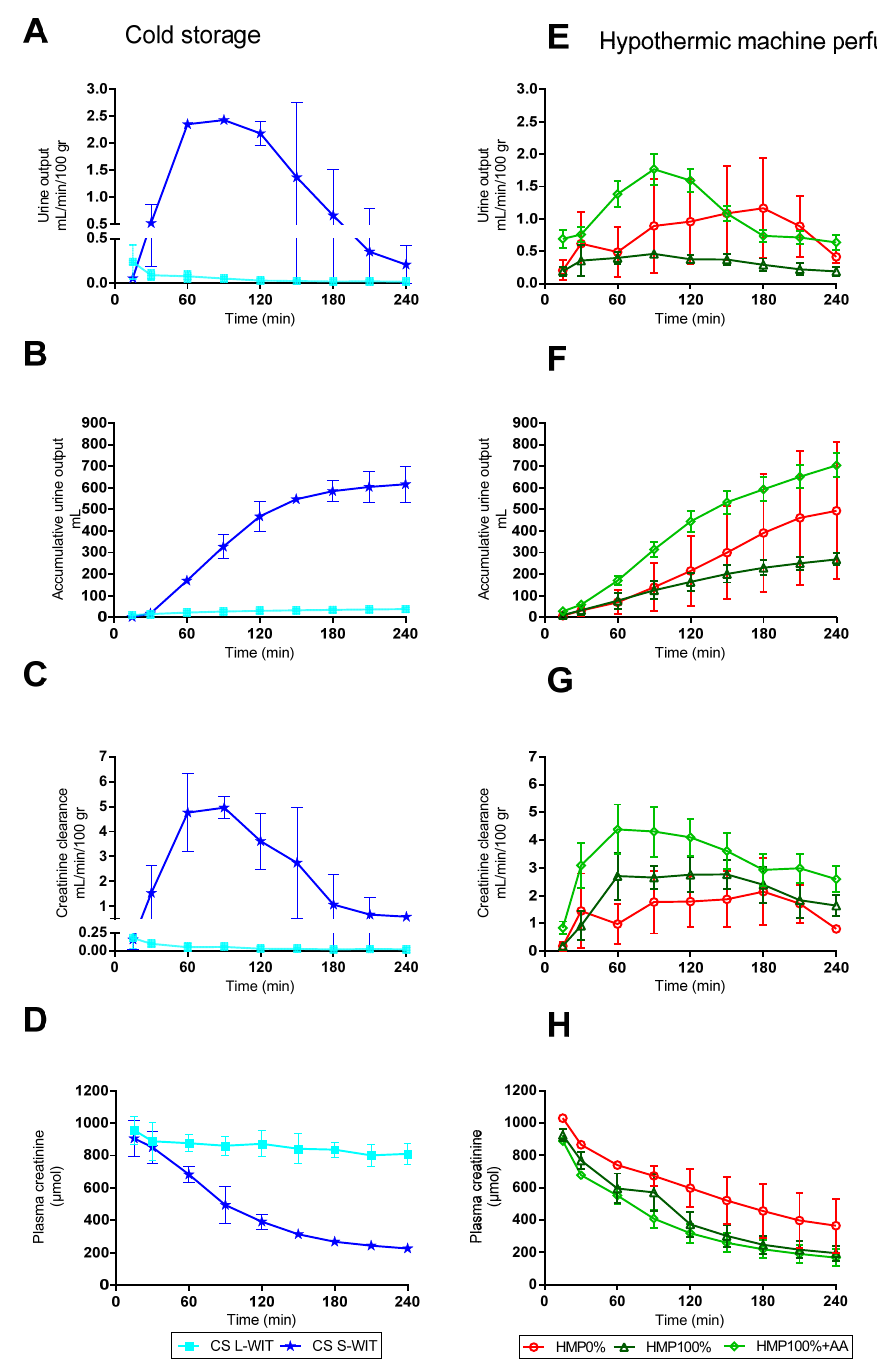
Figure 4. Renal function during normothermic kidney perfusion. Porcine kidneys perfused for 4 h with a blood-based perfusion solution to test kidney function. ( A , E ) Urine production during 4 h NKP for CS and HMP preserved kidneys, ( B , F ) accumulative urine production during 4 h NKP for CS and HMP preserved kidneys, ( C , G ) creatinine clearance during 4 h NKP for CS and HMP preserved kidneys, ( D , H ) serum creatinine levels during 4 h NKP for CS and HMP preserved kidneys. NKP, normothermic kidney perfusion; CS, cold storage; HMP, hypothermic machine perfusion. The data are shown as mean ± SD.